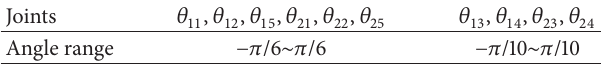
Table 3: The angle range of joints (unit: